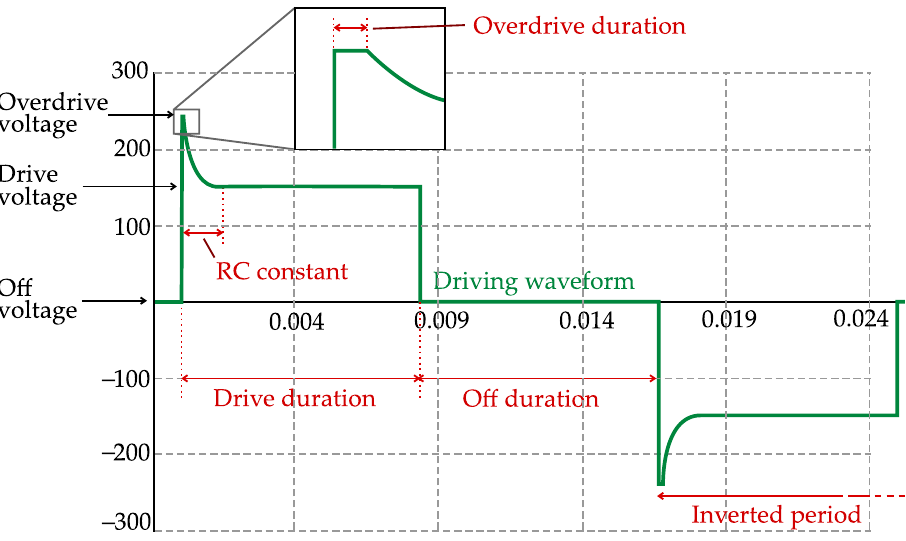
Figure 3. Typical waveform used for cell electro-optical response characterization.